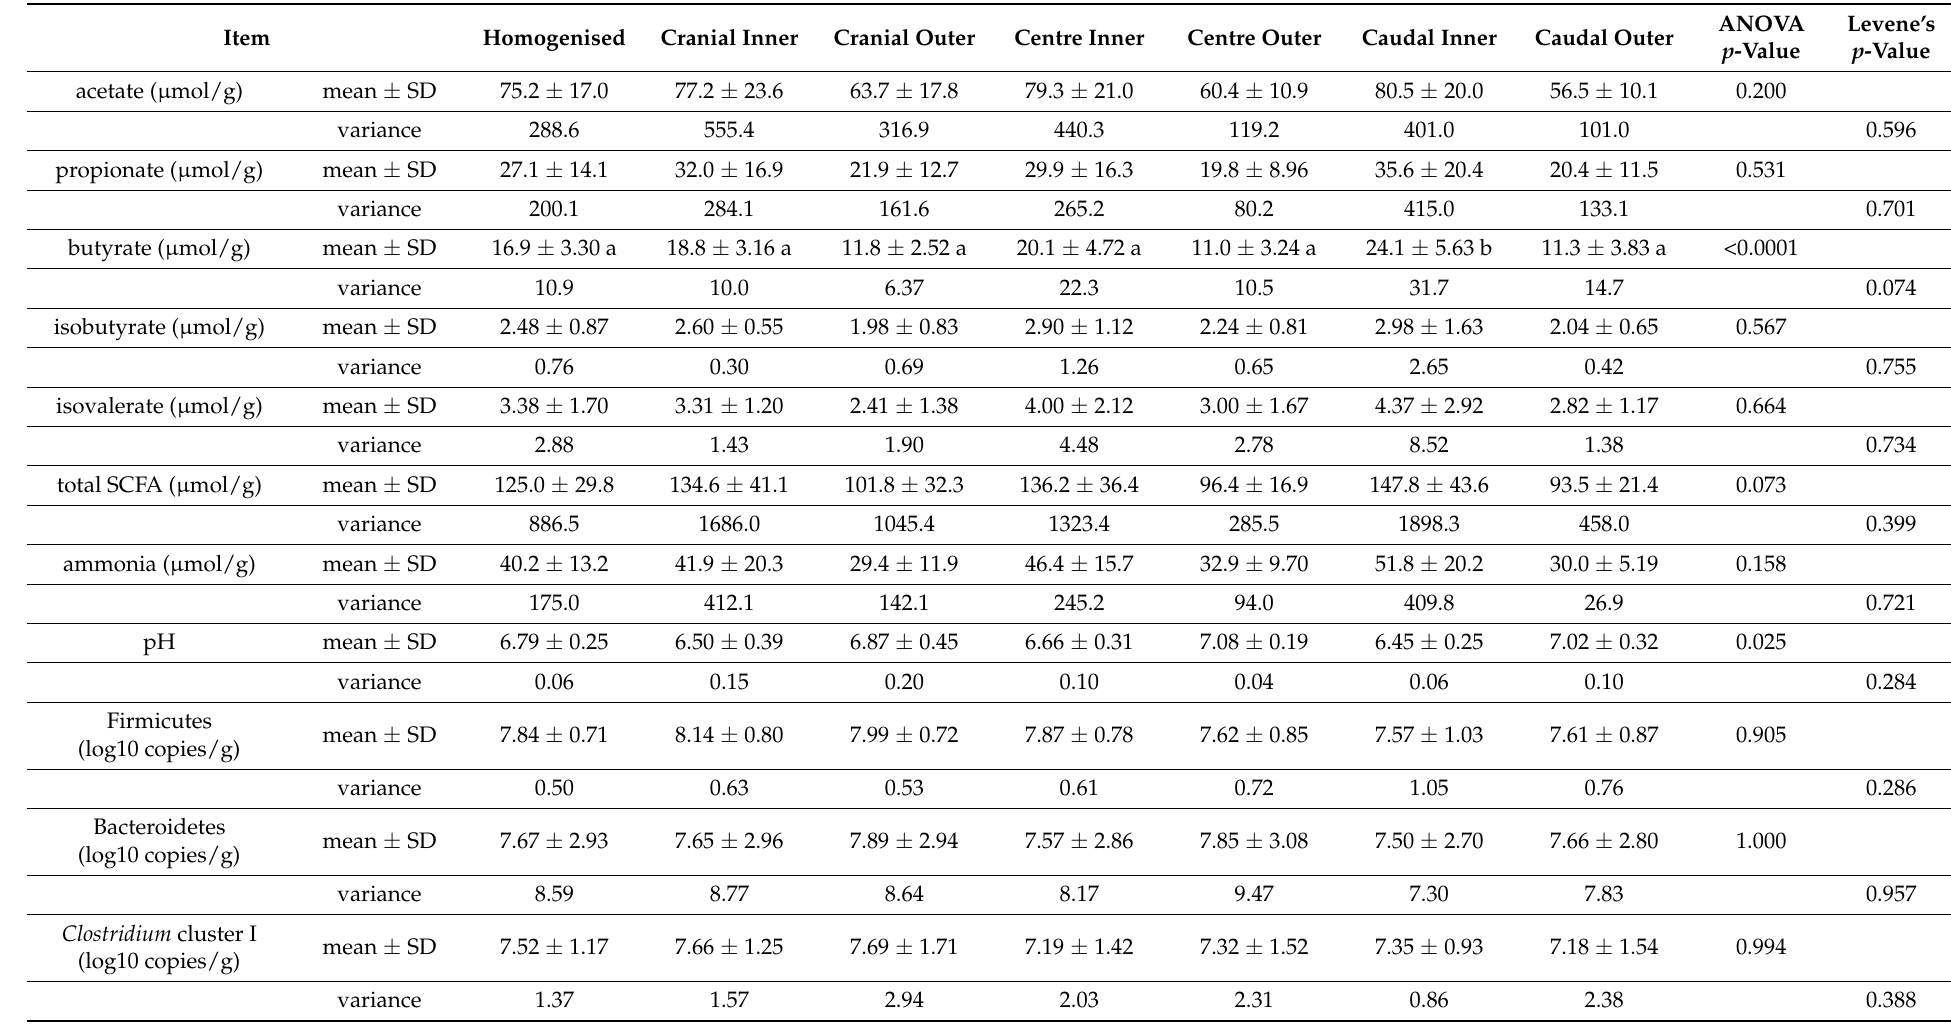
Table 2. Mean, standard deviation (SD) and variance values for short-chain fatty acids, ammonia, pH and microbial populations determined in each subsampling area and in the homogenised stool collected from five different